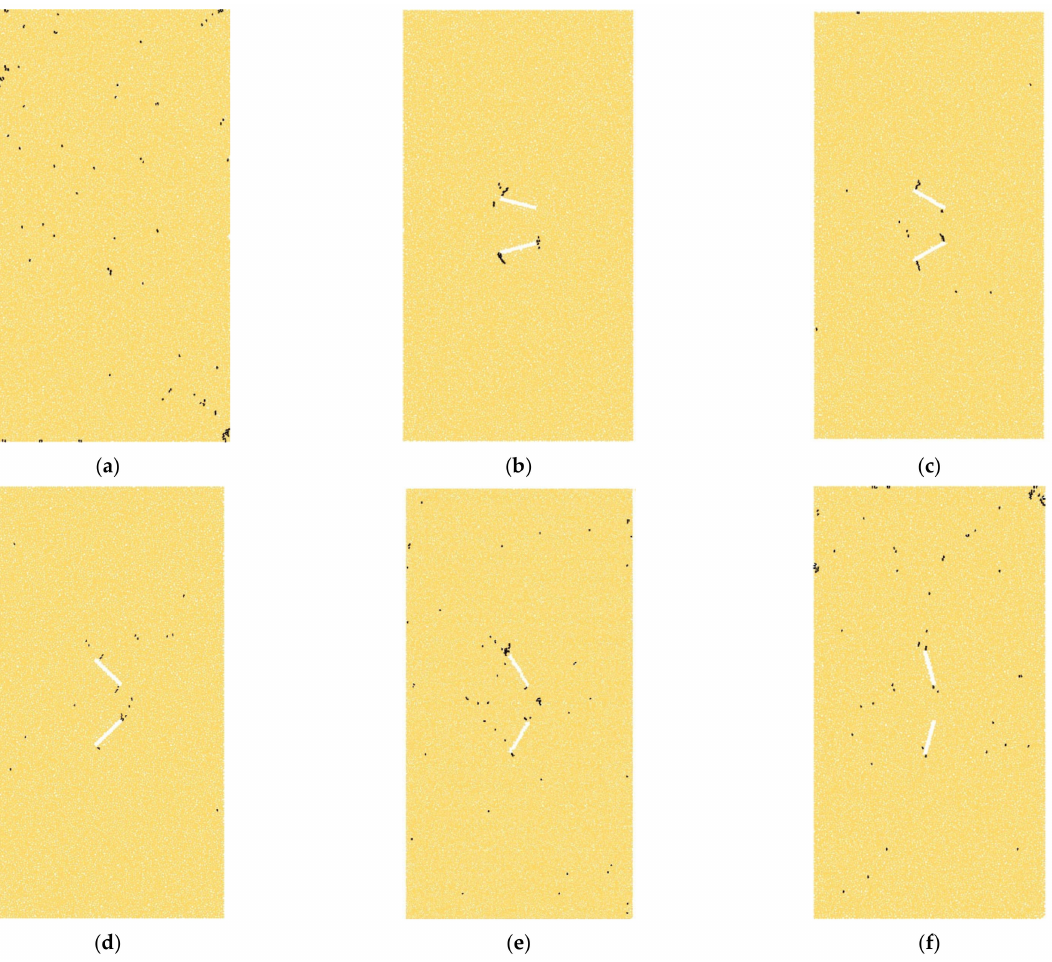
Figure 6. Snapshot of different numerical models under crack initiation stress. ( a ) Intact model; ( b ) β = 15 ◦ ; ( c ) β = 30 ◦ ; ( d ) β = 45 ◦ ; ( e ) β = 60 ◦ ; ( f ) β = 75 ◦